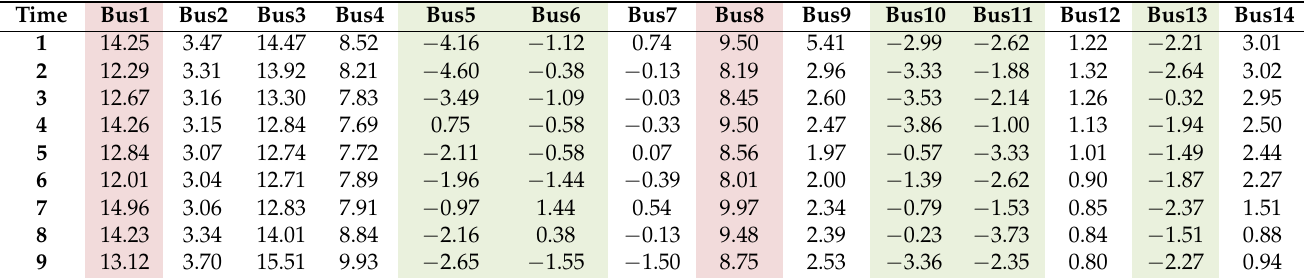
Figure 8. Performance of the ANN- BPSO optimization. Table 9. Power in MW for all buses in the 14-bus VPP system in the case of using ANN-BPSO.